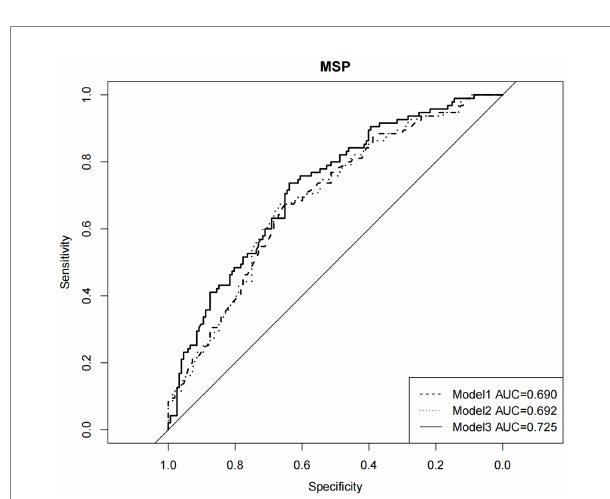
FIGURE 2 Receiver operator characteristic curve for demographic factors, HIV awareness variables, child sexual abuse in hierarchical logistic regression models predicting multiple sexual partners ( N